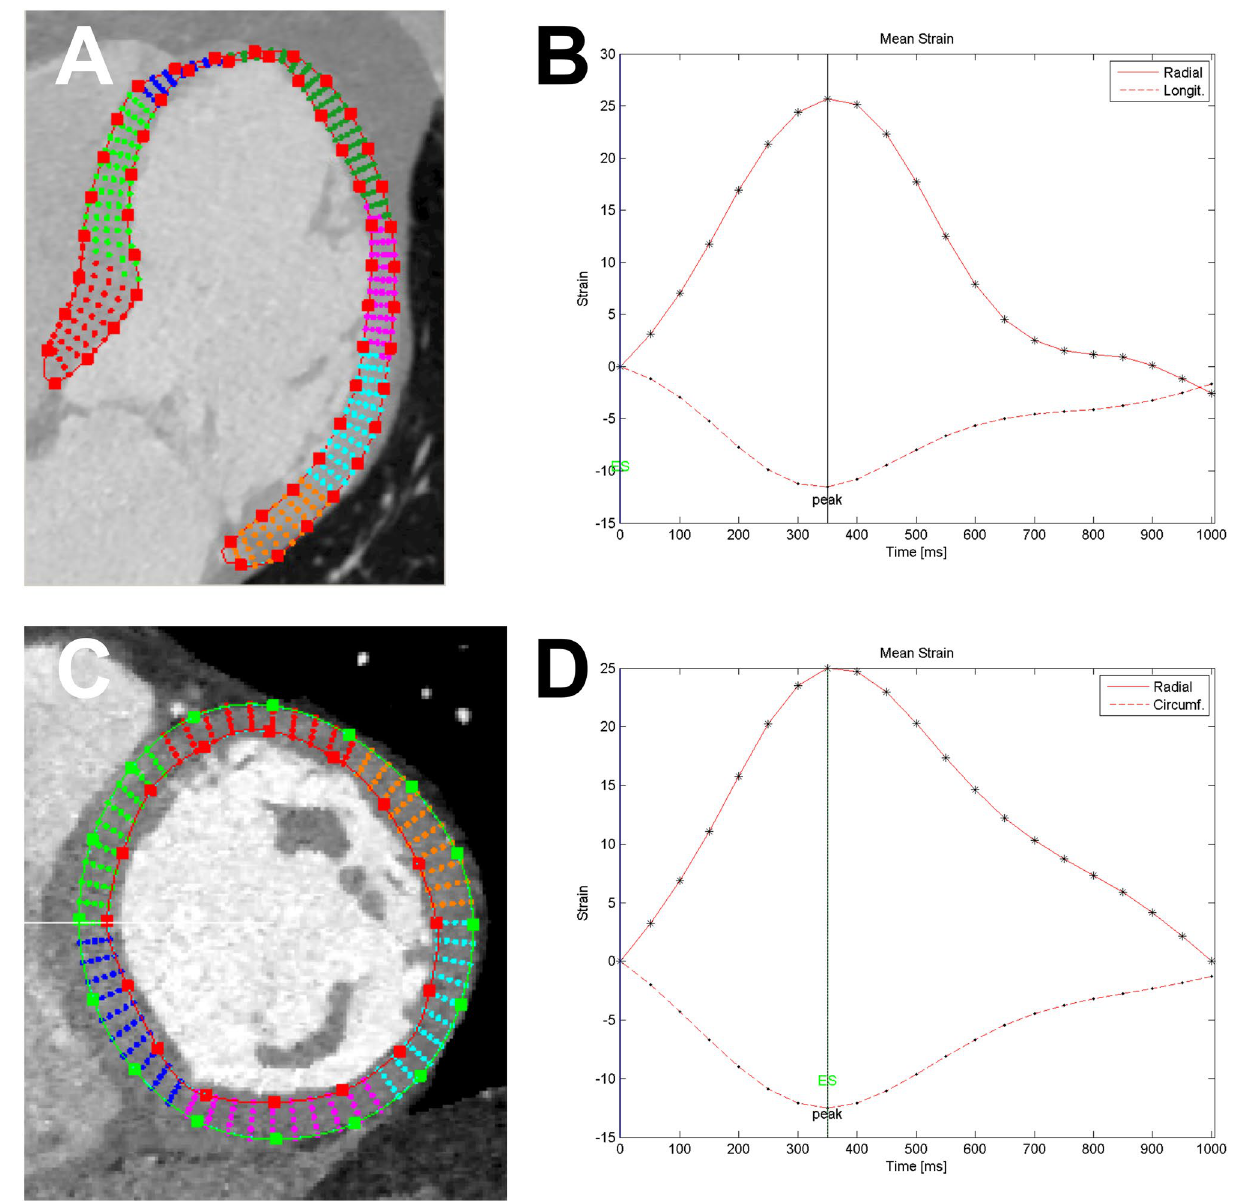
Figure 2. Example of strain measurement in SegmentCT (Medviso, Lund, Sweden). Images ( A ) and ( B ) show an example of strain measurement in a four-chamber view of the left ventricle with the corresponding strain curve for radial and longitudinal strain. Images ( C ) and ( D ) show an example of strain measurements in a short axis view of the left ventricle with the corresponding strain curves for radial and circumferential strain.